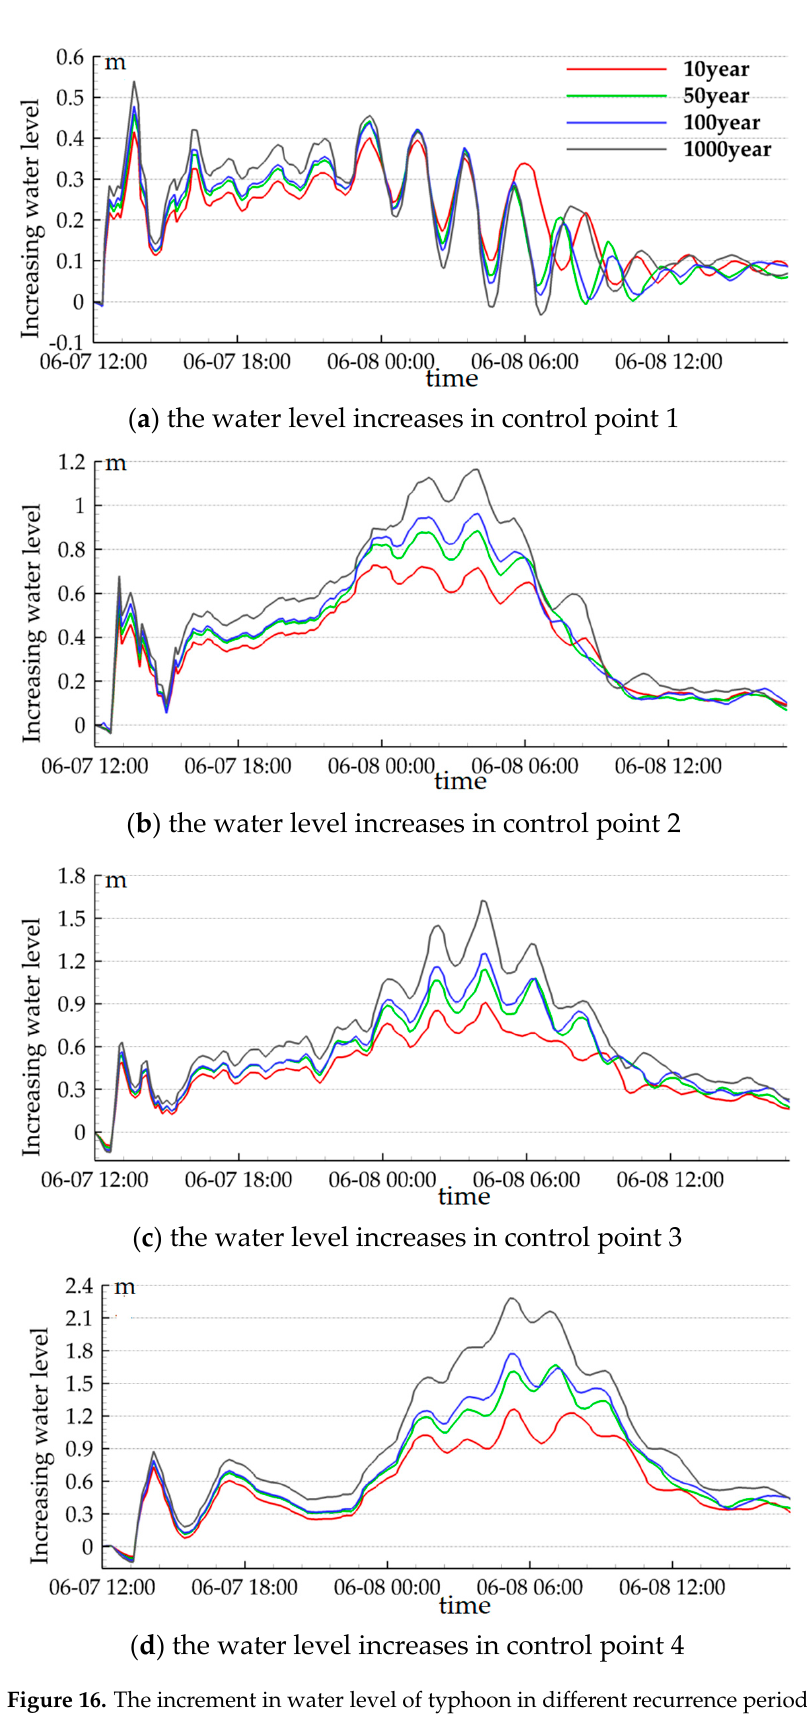
Figure 16. The increment in water level of typhoon in different recurrence periods.